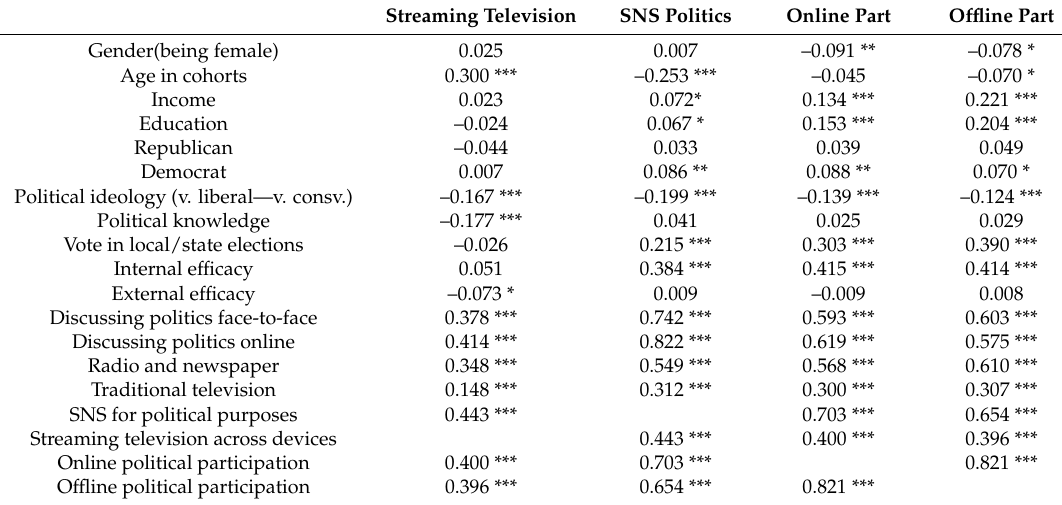
Table 1. Pairwise correlations for frequency of streaming television, using social network sites for political purposes as well as online and offline political